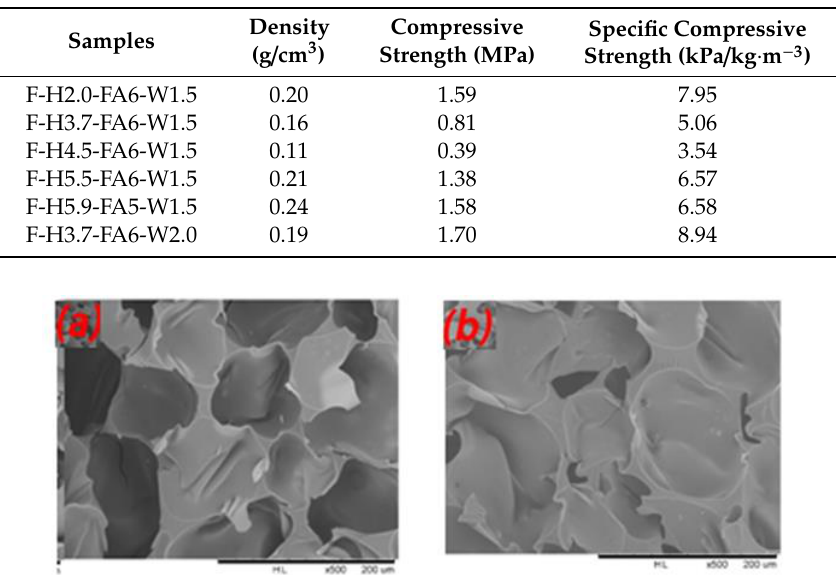
Figure 8. Effect on foam morphology of different proportions of water. ( a ) F-H3.7-FA6-W2.0; ( b ) F-H3.7-FA6-W1.5.